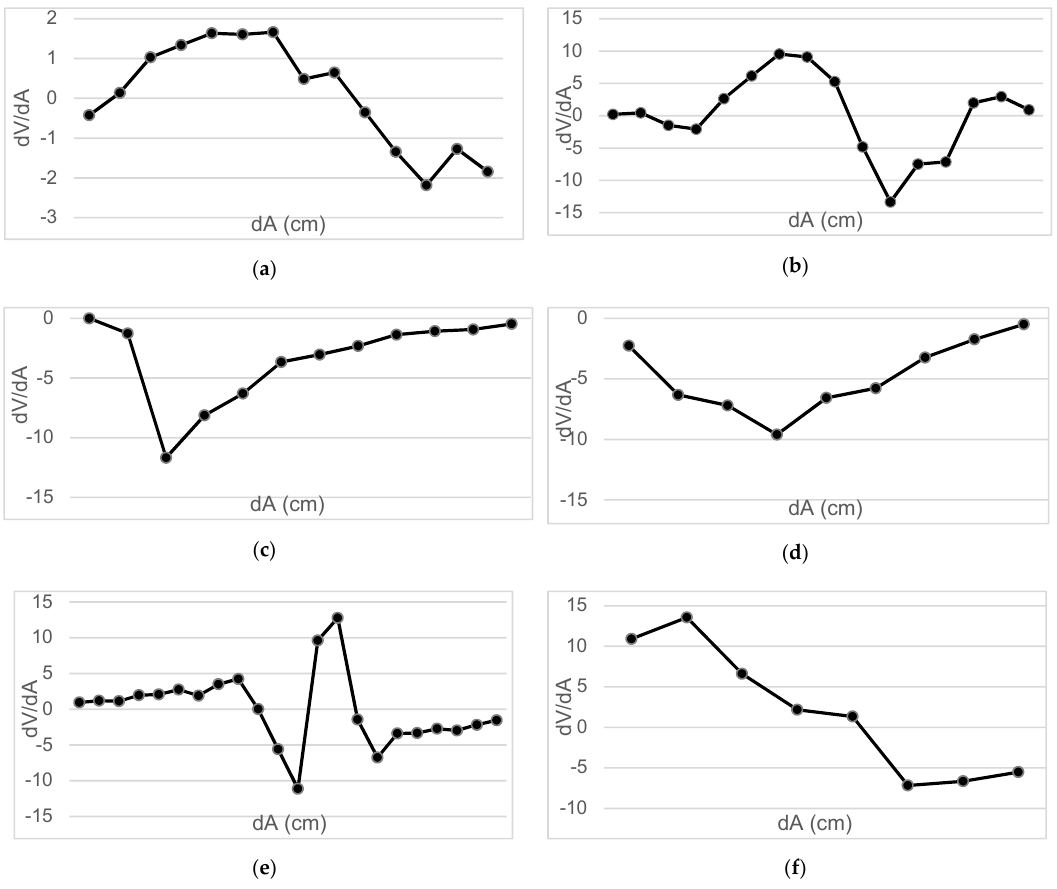
Figure 12. ( a ) Gradients Test 4.1; ( b ) Gradients Test 4.2; ( c ) Gradients Test 4.3; ( d ) Gradients Test 4.4; ( e ) Gradients Test 4.5; ( f ) Gradients Test 4.6.